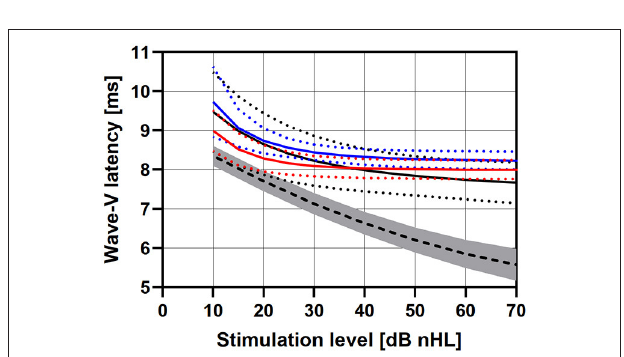
FIGURE 1 | (A) Individual VSB evoked ABR wave-V latencies for all applied stimulation levels of all included patients with OW placement (black), Incus placement (blue), and RW placement (red). The dashed curves show the mean wave-V reference data of an acoustic click stimulation for the ABR system used in the study. Gray areas show the standard deviations. (B) Individual wave-V latencies after level correction for coupling efficiency, i.e., reduction by 3PTA VIB minus 3PTA BC . (C) Individual wave-V latencies after correction for the individual ABR threshold, aligned to a stimulation level of 10 dB nHL.